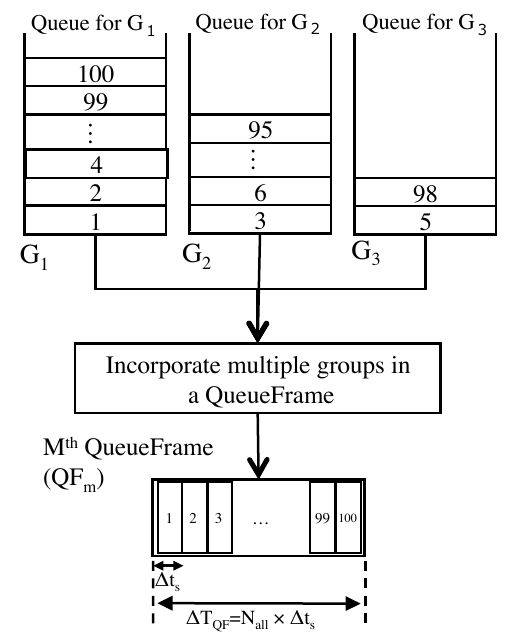
Figure 4. A composition of a QueueFrame